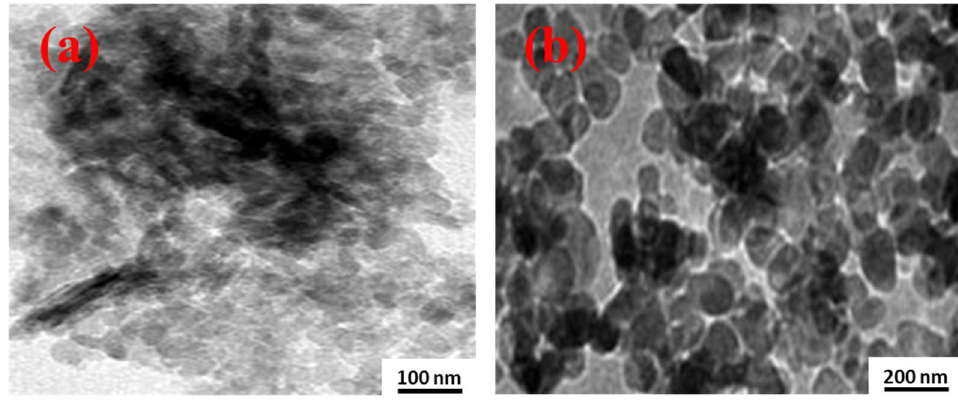
Figure 2. ( a – c ) SEM images of S1, ( d – f ) S2, and ( g – i ) S3 thin films at different magnifications.